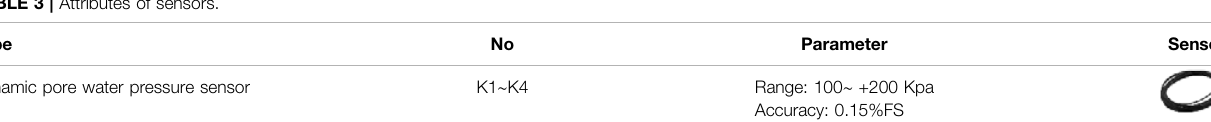
TABLE 3 | Attributes of